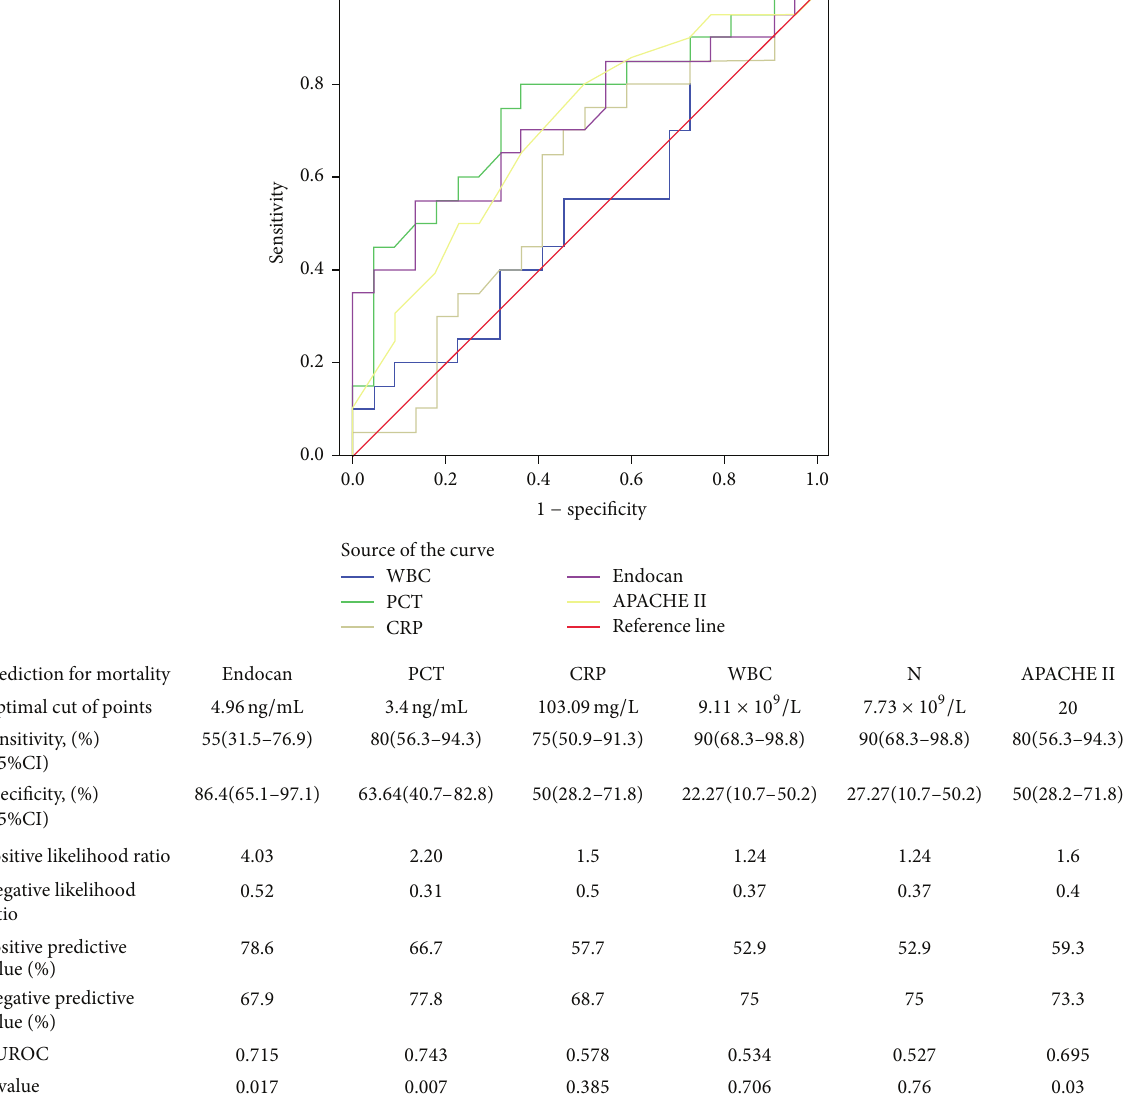
Figure 2: Motality prediction by plasma levels of endocan, PCT, CRP, WBC and Neutrophil counts and APACHE II scores in patients with acute respiratory distress syndrome using the receiver operating characteristic (ROC) curves.The optimal cutoff points for each plasma biomarker level and severity score were listed in the attached table, 𝑃 value less than 0.05 was considered statistically significant.